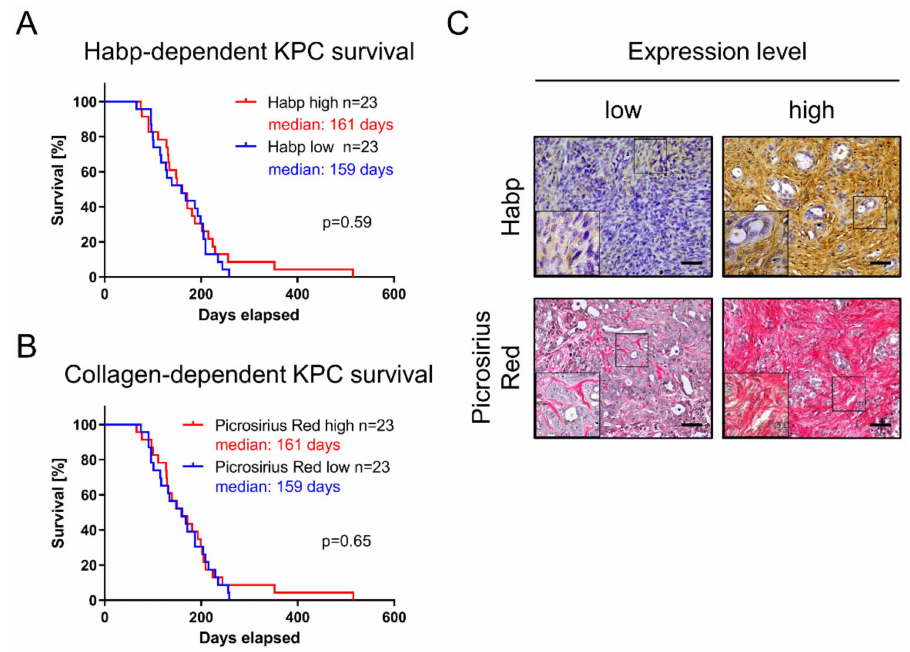
Figure 4. Influence of tumor-stroma composition on KPC survival. Extracellular-matrix (ECM) components ( A ) Habp representing hyaluronic acid (HA) and ( B ) collagen via Picrosirius staining were investigated with regard to KPC survival. ( C ) Representative pictures for low and high expression levels, respectively. Scales equal 50 µ